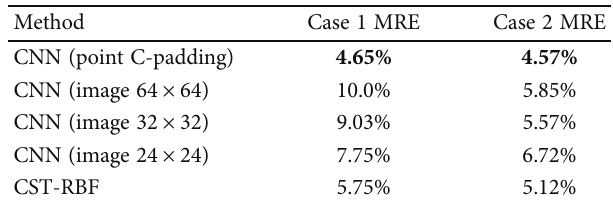
Figure 12: The contributions of di ff erent airfoil positions to Cl, Cd, and Cl/Cd. Red spots represent the positive e ff ect on them and the blue spots represent the negative e ff ect on them; the larger the spots, the greater the impact is. The fi rst column shows the contributions of di ff erent positions to Cl, the second column shows the contributions of di ff erent positions to Cd, the third column shows the contributions of di ff erent positions to Cl/Cd, and the fourth column shows that the real Cp distribution comes from each data Table 3: Comparison of prediction performance under a small amount of data.